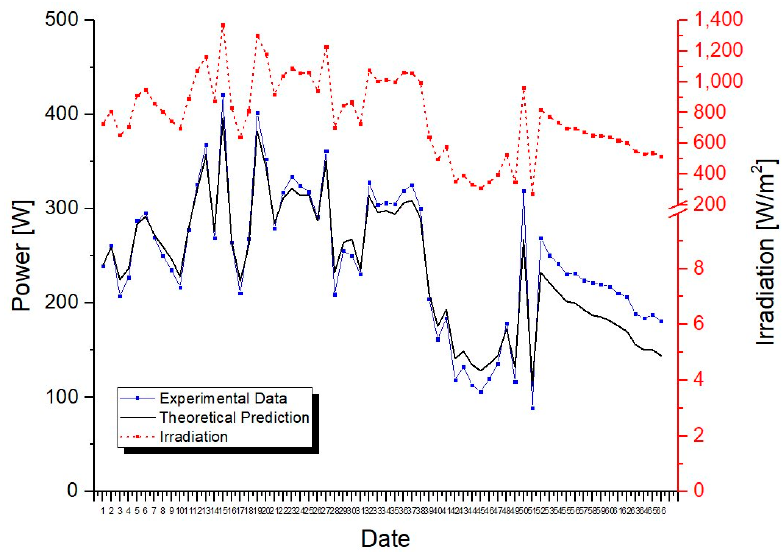
Figure 21. Theoretical prediction and measured data at 5-min intervals from 11:03. to 16:28 on 25 August 2017 (white painted back ground).